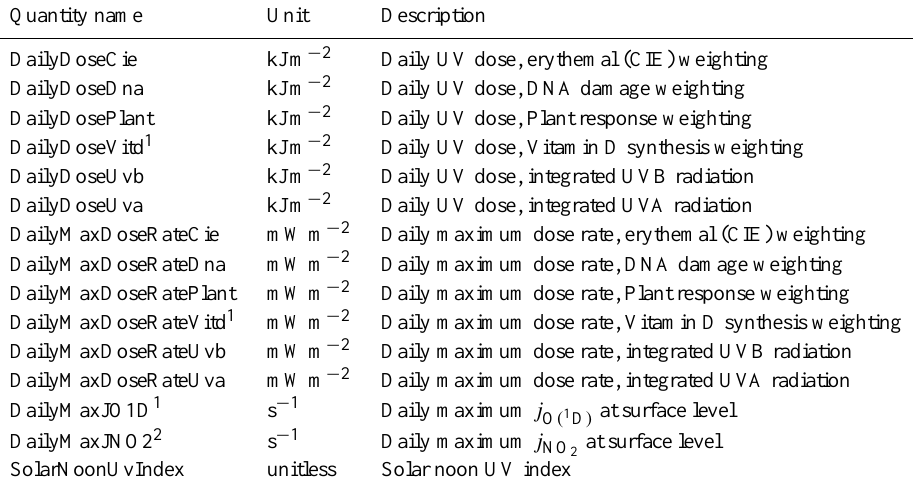
Table 1. Description of the surface UV radiation quantities stored in the OUV product version 1.20. The quantities and the biological weighting functions are defined in Sect. 2.4.